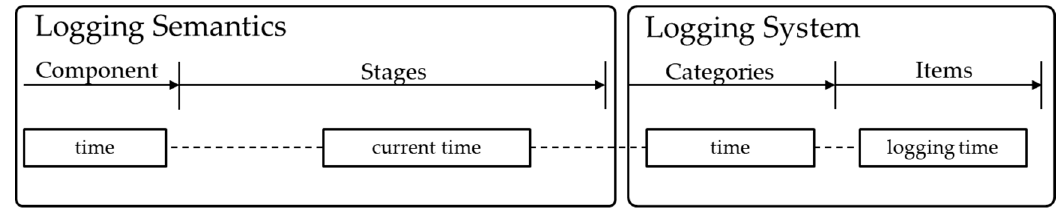
Figure 6. Time components and logging items.